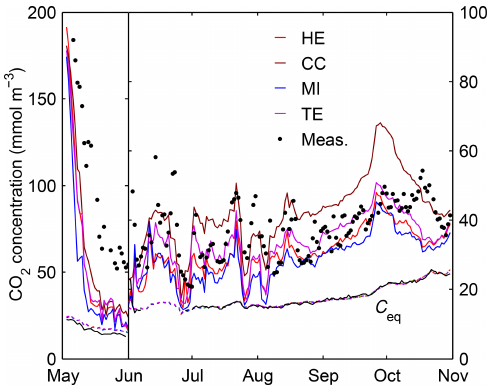
Figure 4. Simulated CO 2 concentrations (mmolm − 3 ) in the surface layer (0–0.5m) obtained with each GEM and the daily averages of the automatic measurements at 0.2m in Lake Kuivajärvi in May– October 2013. Also shown are the atmospheric equilibrium concen- trations of CO 2 ( C eq ) obtained from the simulations (dotted colored lines) and calculated from the measured atmospheric CO 2 concen- tration and surface water temperature (solid black line). Note the different vertical scales in May and in